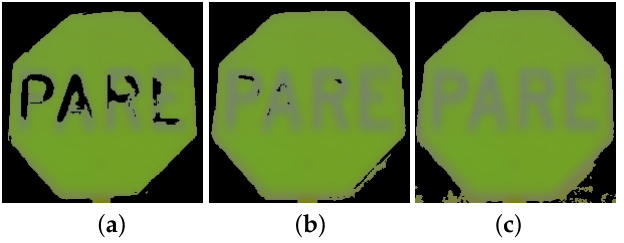
Figure 10. Discarding the background in the Y channel with different thresholds: ( a ) σ Y = 55; ( b ) σ Y = 60; and ( c ) σ Y =